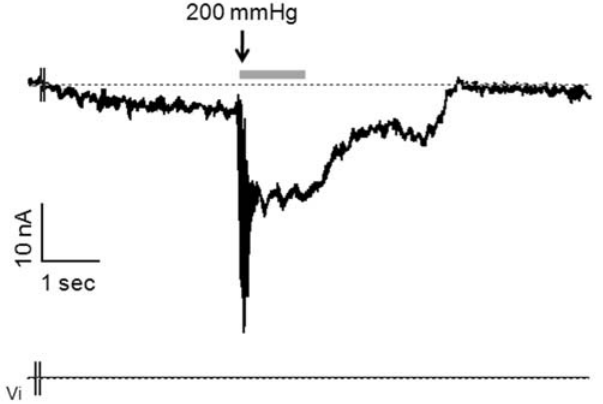
Figure 8. Suction initiates spontaneous inward currents in MCs. MCs are believed to function as a mechanoreceptors. To determine whether they respond to touch, suction (200 mmHg) was applied to transfected MCs from a rat footpad. Suction induced a strong, non- delayed, inward transient current. The decrease of inward currents at the second part of the recording is explained by the time required to